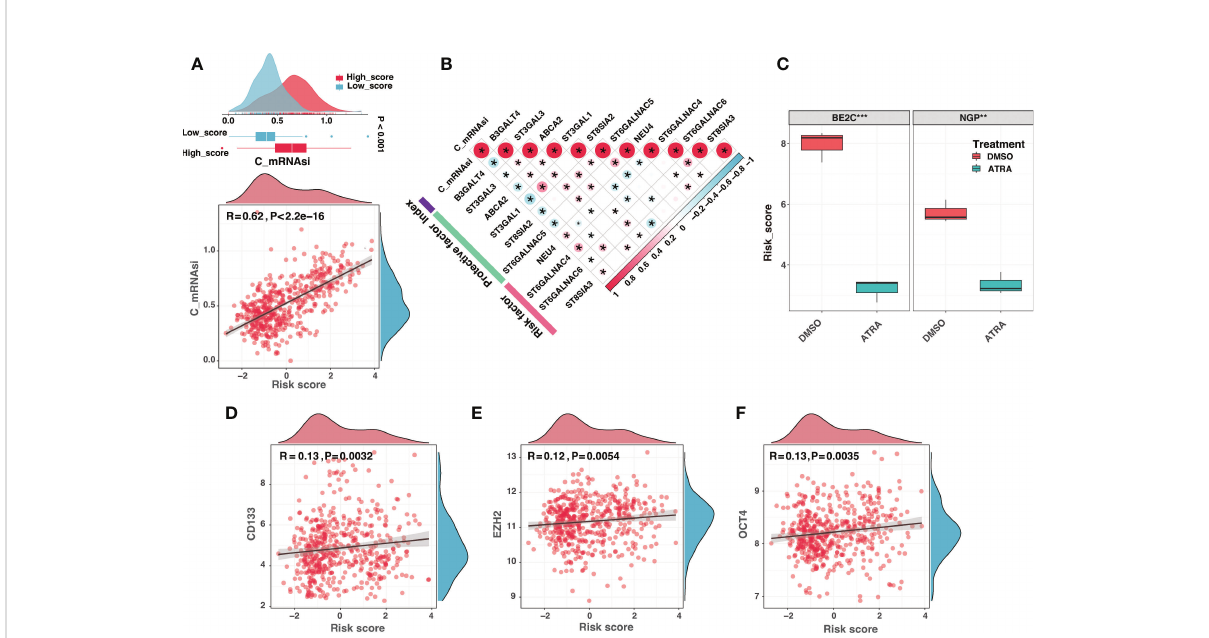
FIGURE 12 The high-score group presented with a high degree of dedifferentiation. (A) The comparison of the corrected mRNAsi (c_mRNAsi) between different risk groups (top) and correlation analysis between the risk score and the c_mRNAsi (bottom). (B) The correlation analysis between the c_mRNAsi and signature gene expression. (C) The comparison of risk scores between neuroblastoma cells treated with dimethyl sulfoxide (DMSO) or all-trans retinoic acid (ATRA) in BE2C and NGP cell lines. (D-F) The risk score was signi fi cantly positively associated with multiple stemness markers of neuroblastoma, including CD133 (D) , EZH2 (E) , and OCT4 (F) . (*: P < 0.05, **: P < 0.01, ***: P <